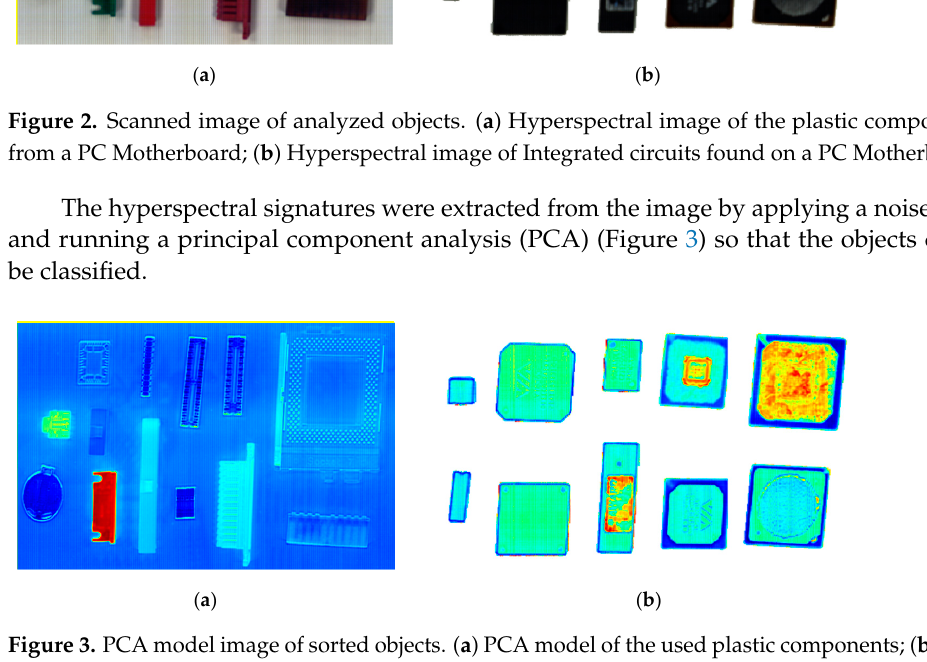
Figure 3. PCA model image of sorted objects. ( a ) PCA model of the used plastic components; ( b ) PCA model of the used integrated circuits. model of the used integrated